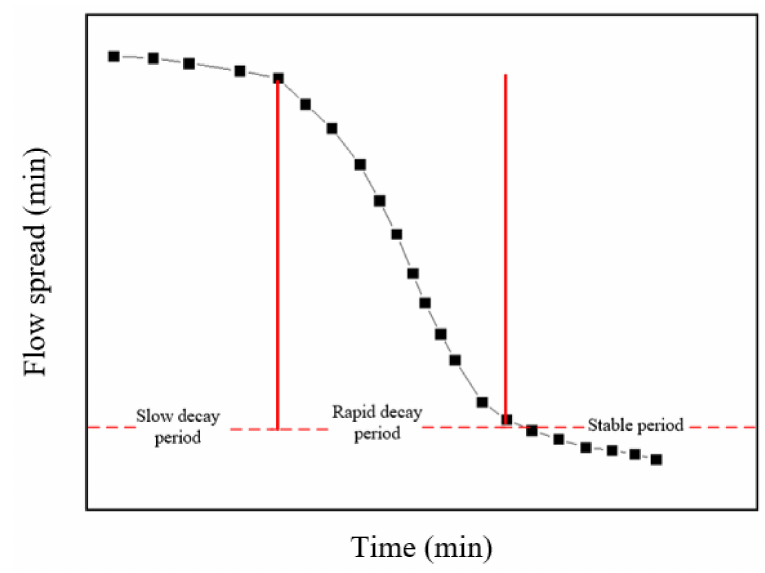
Figure 9. Trend of fluidity of cement paste containing SF over